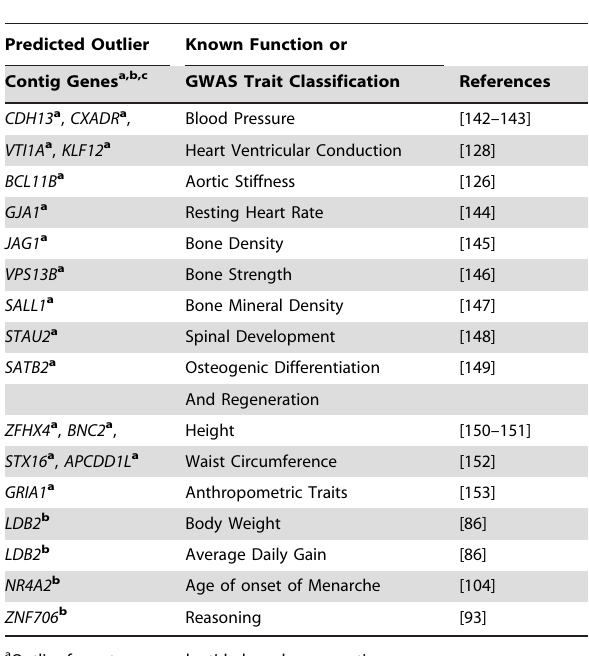
Table 5. Biologically relevant bobwhite NB1.0 simple de novo outliers from a genome-wide analysis of divergence with the zebra finch genome ( T. guttata